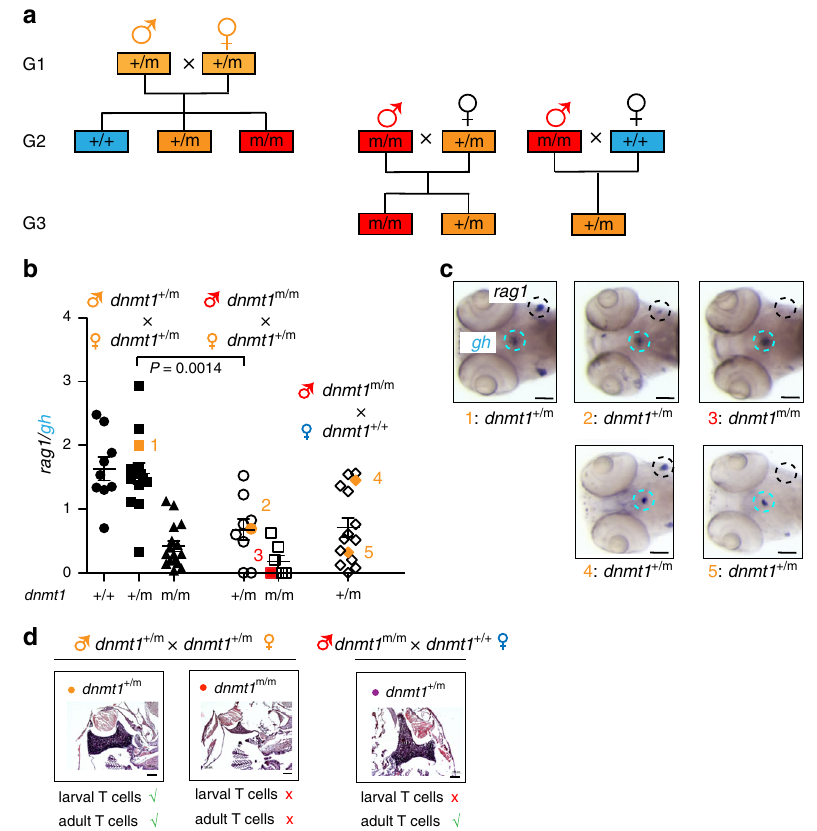
Fig. 3 Impaired T cell development in 5 dpf larvae. a Structure of pedigrees. A cross of male and female carriers gives rise to the three genotypes of the G2 generation that are used to establish the G3 generation. b The rag1/gh ratio as determined by RNA in situ hybridization is shown for 5 dpf fi sh of the indicated genotypes (bottom) arising from the indicated parental genotypes (top); male genotypes are shown in upper row. Each data point represents one animal; t test, two-tailed; mean ± s.e.m. c Representative RNA in situ patterns on which the calculation of rag1/gh ratios was done are shown on the right for the animals identi fi ed by numbers in panel ( b ). The thymus region (identi fi ed by rag1 signal) and the hypohysis (identi fi ed by the gh signal) are encircled; because of the cell-type speci fi city of the mutant phenotype, the rag1/gh ratio serves as a convenient normalization measure for the RNA in situ hybridization protocol. d Thymopoiesis in adult animals of the indicated generations and genotypes. Histological sections of thymi were stained with hematoxylin/eosin; note the alymphoid thymus in dnmt1 m/m fi sh. In ( c , d ), scale bars: 0.1 mm. Source data are provided as Source Data fi